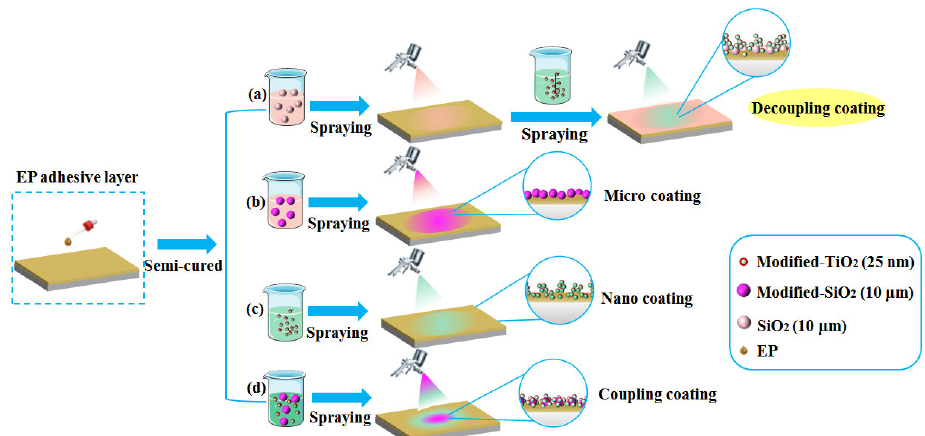
Fig. 1 Schematic illustration of the fabrication process for (a) decoupling coating, (b) micro coating, (c) nano coating, and (d) coupling